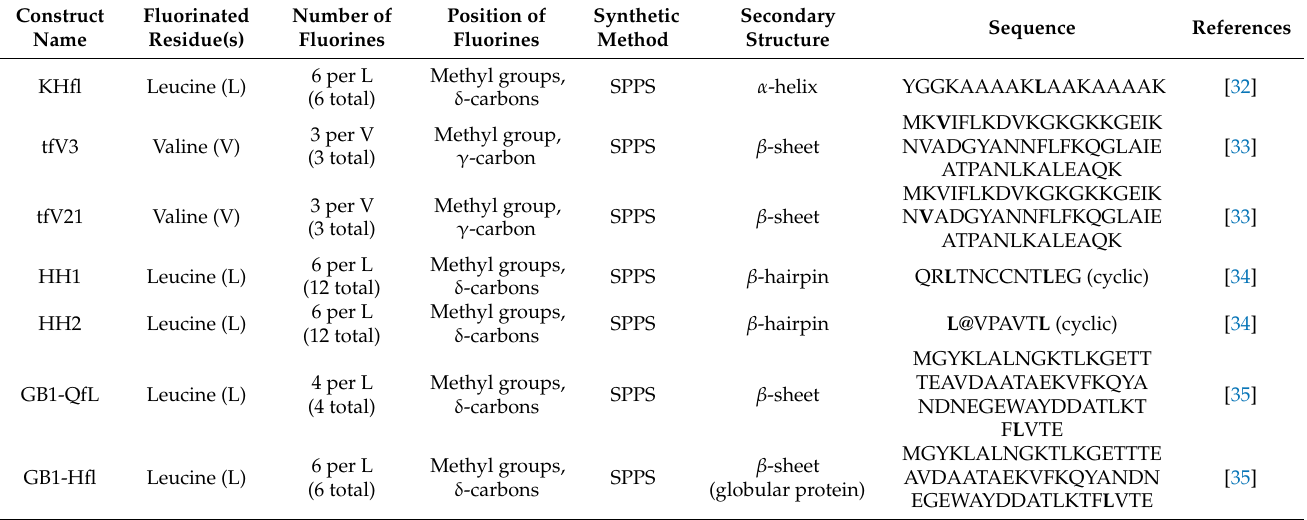
Table 1. Summary of fluorinated proteins and peptides constructs alongside their accompanying one letter AA sequences in the order they are examined to discern the impact of fluorination on secondary structure.